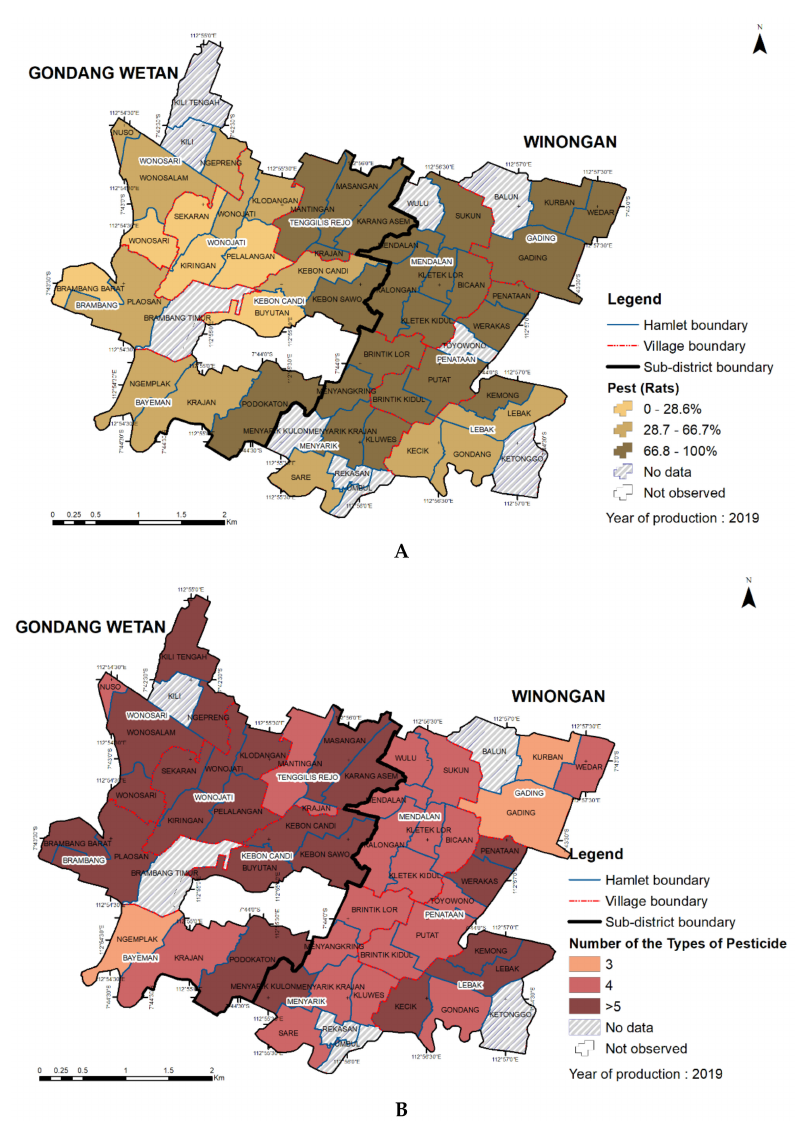
Figure 10. Spatial distribution of the intensity of pest/rodents ( A ) and number of types of pesticide applied ( B ) at hamlet